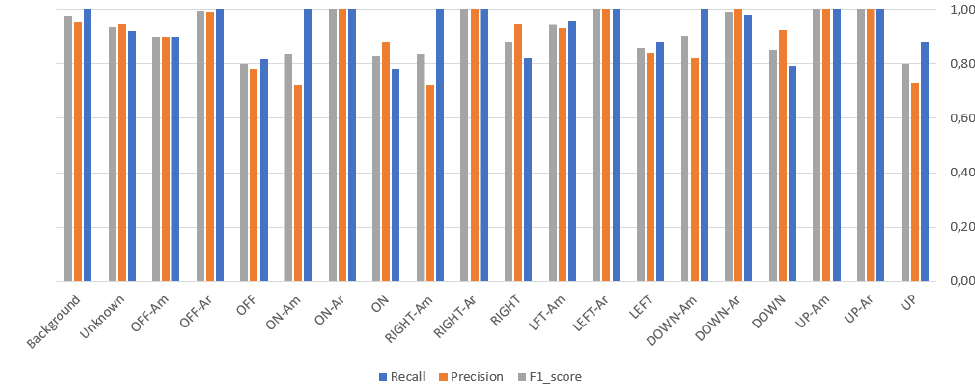
Figure 9. Performance measures and results.